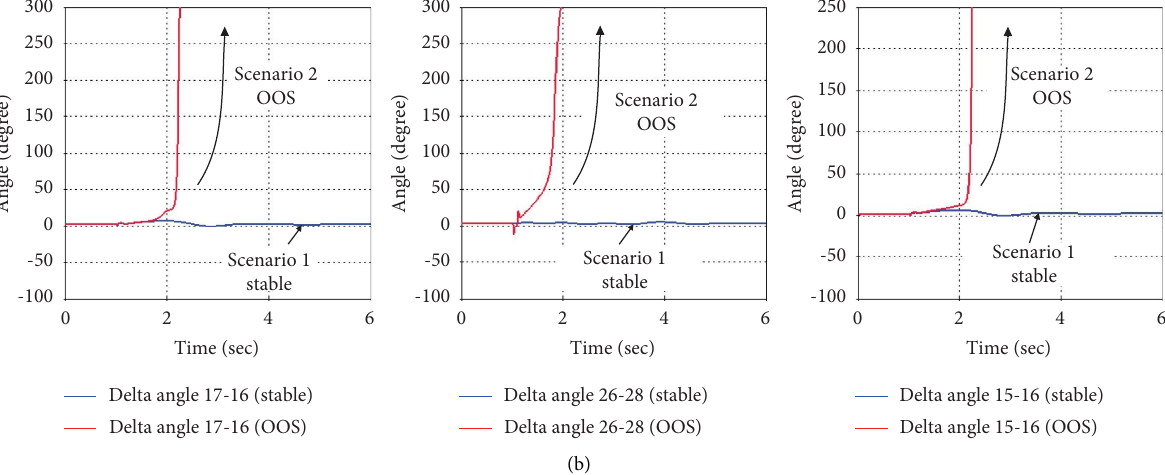
Figure 22: Comparison between stable and out-of-step conditions: (a) tie lines’ active power and (b) voltage angle